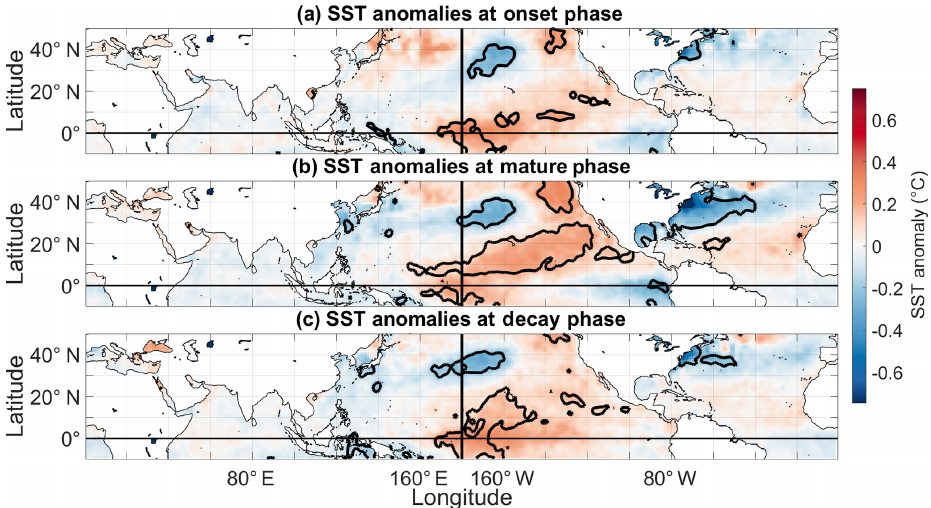
Figure 10. Composite mean SST anomalies corresponding to (a) onset, (b) mature, and (c) decay phases of negative LIS temperature events. Contours enclose regions of 5% statistical significance, as determined by a one sample t test.